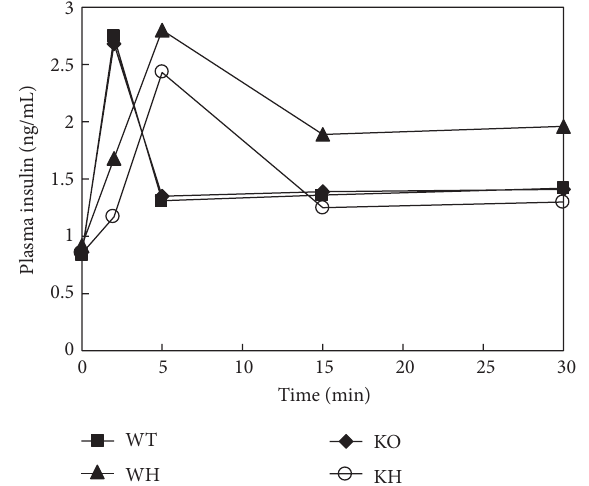
Figure 3: The curve of insulin releasing test. WT: wildtype mice; WH: wildtype mice with high-fat diet; KO: ACE2 knockout mice; KH: ACE2 KO mice with high-fat diet.